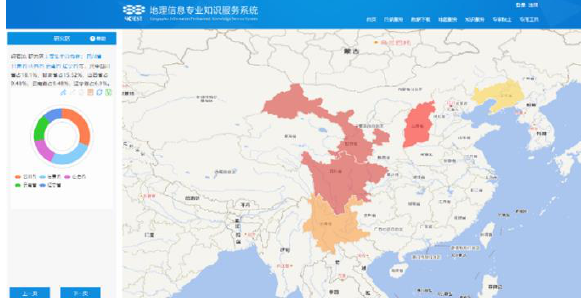
Figure 8 . Recommended applications for the research area.